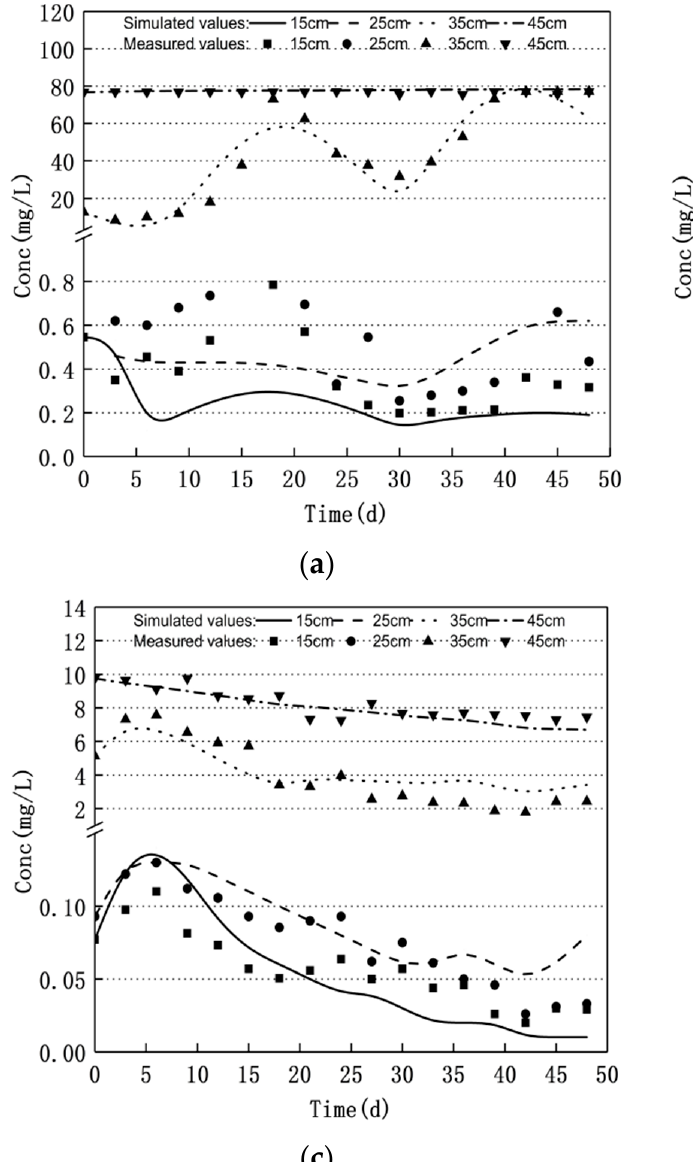
Figure 6. The process of nitrogen change in fine sand (( a ) nitrate nitrogen; ( b ) nitrite nitrogen; ( c ) ammonium nitrogen). Table 5. Model fitting effect.